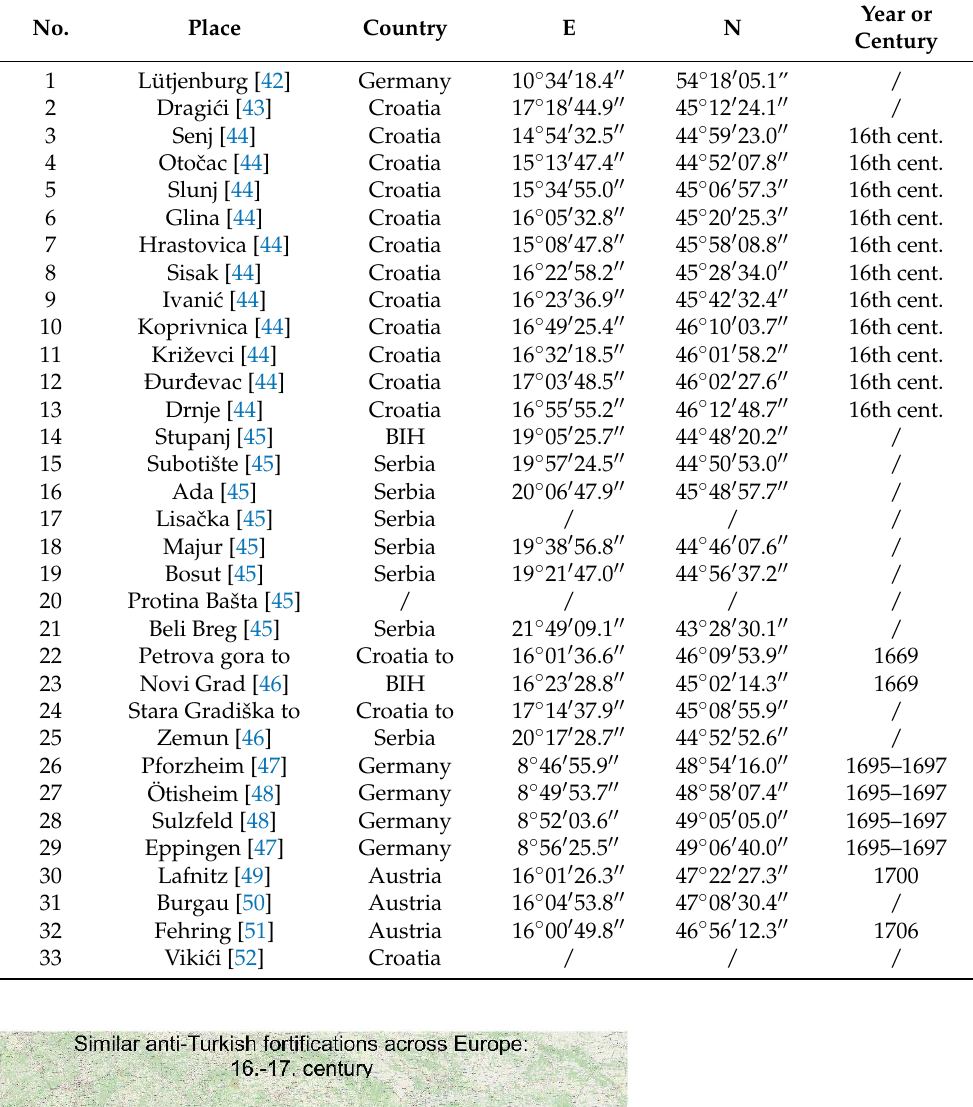
Table 1. ˇCardaks across Europe.